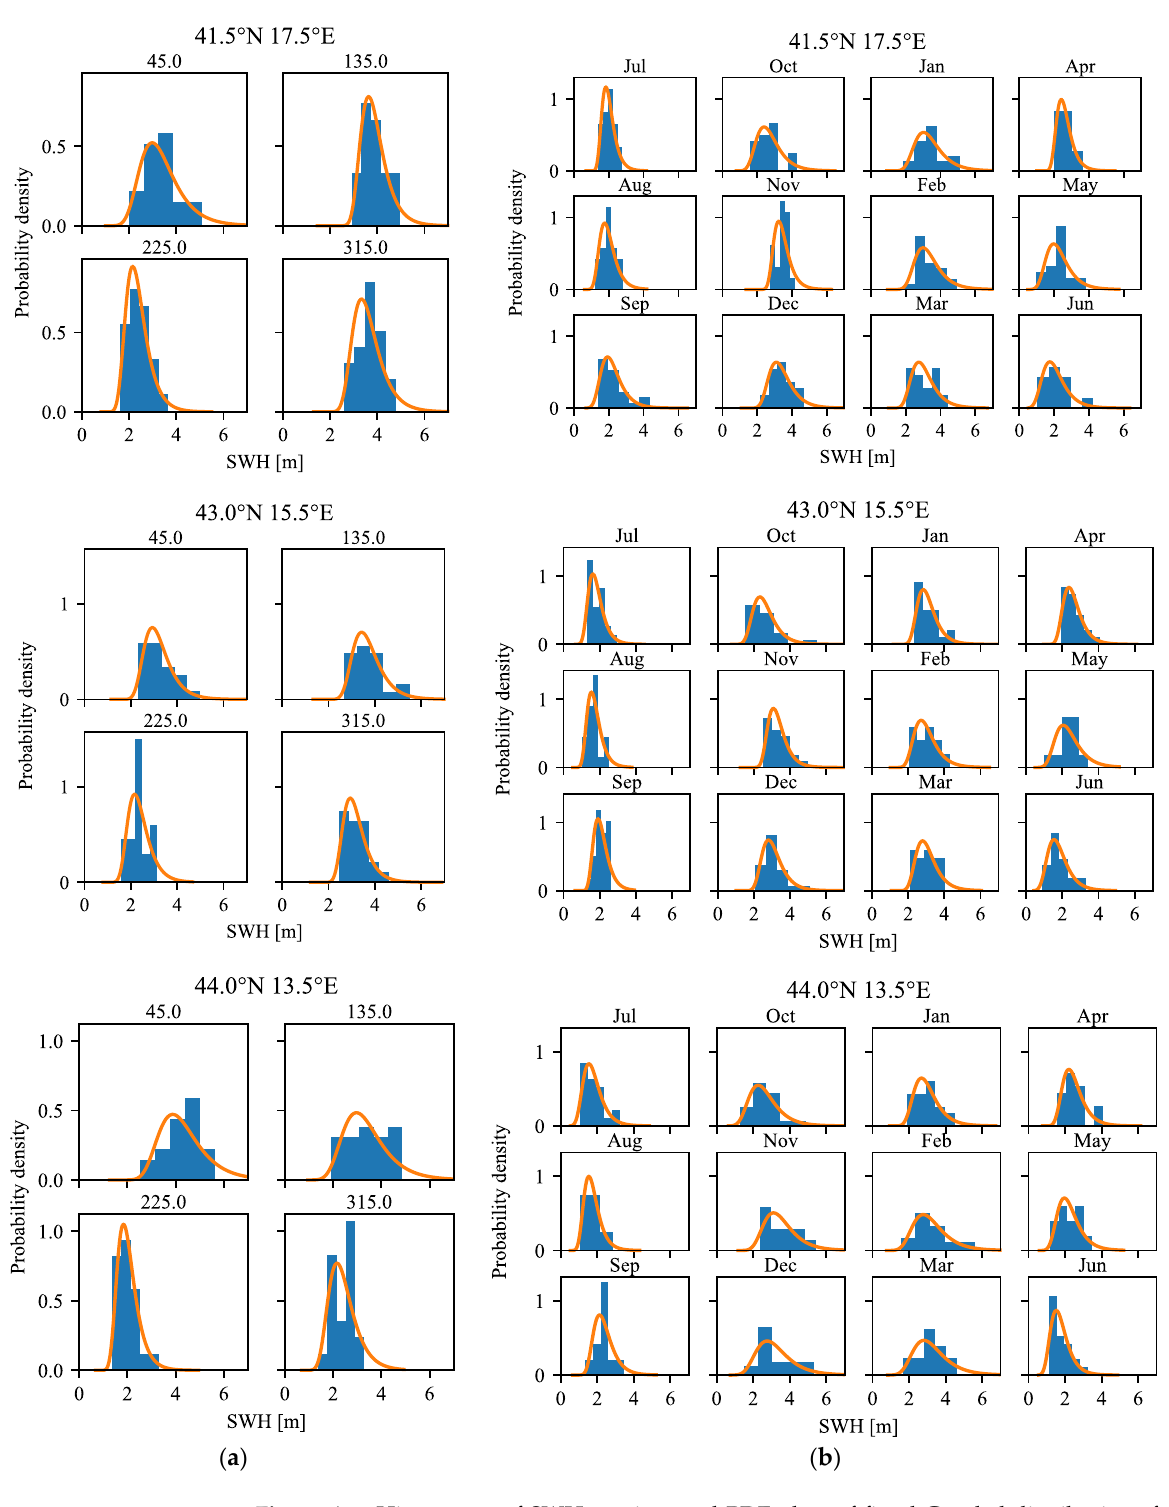
Figure A3. Histograms of SWH maxima and PDF plots of fitted Gumbel distributions for three characteristic locations: ( a ) Directional maxima; ( b ) Monthly maxima.